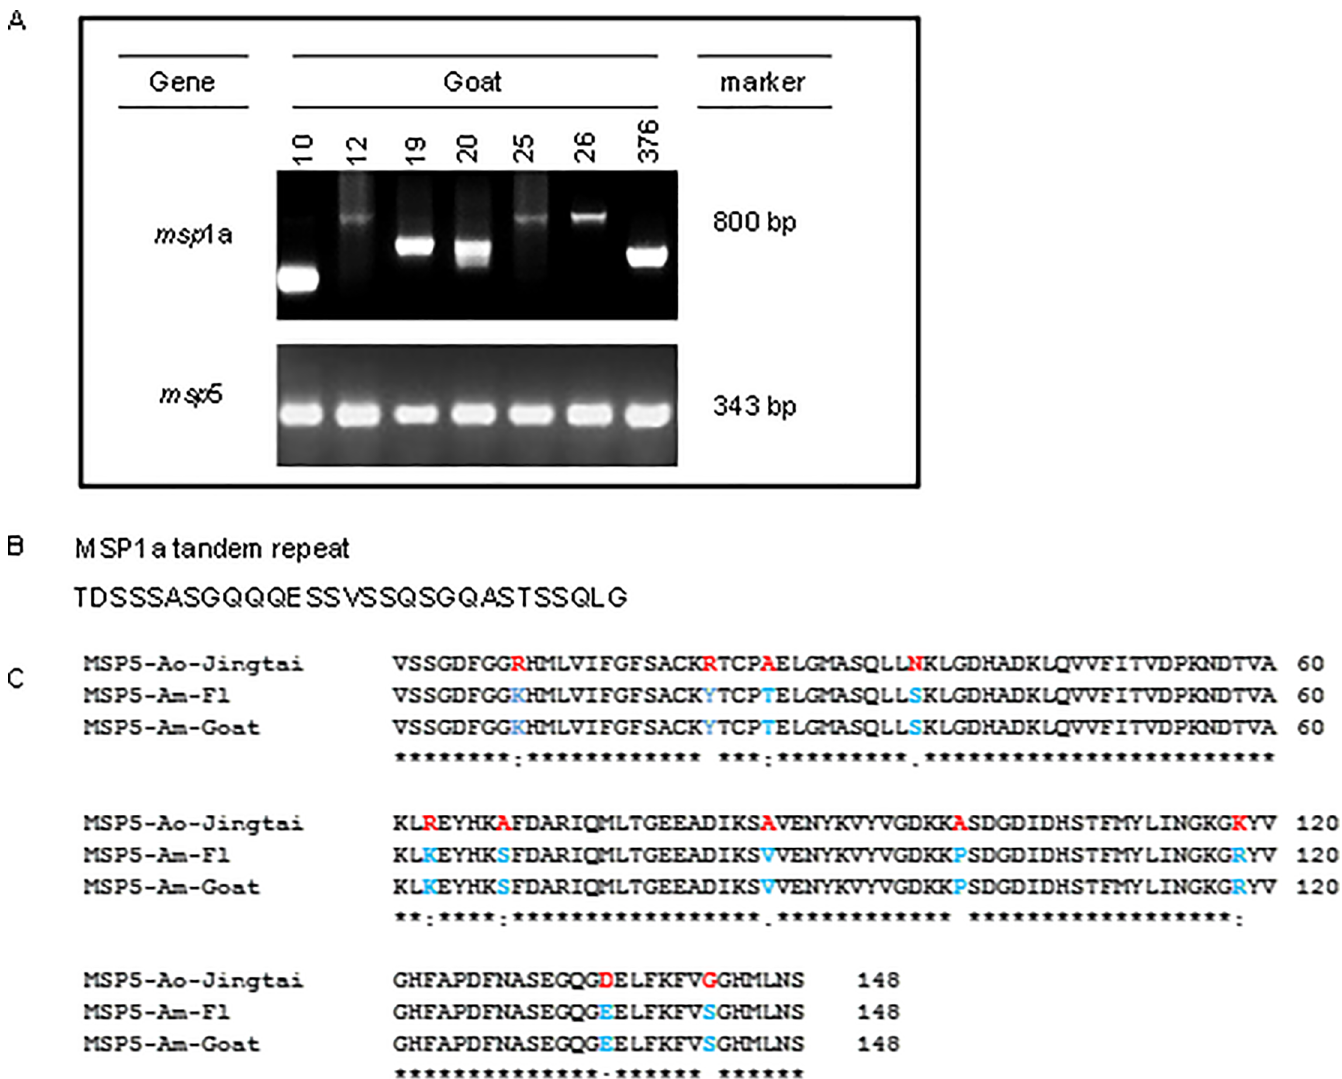
Fig 1. Detection of A . marginale msp 1aand msp 5genes in infected goats. A) 2% agarose gel detecting msp1a and msp5 , B) MSP1a tandem repeats and C) alignment of MSP5 between Anaplasma ovis (Ao Jintai), Anaplasma marginale Florida (Am-Fl) and Anaplasma marginale from a Brazilian goat (Am-Goat). Red indicates variation in the A . ovis MSP5 protein and blue highlights identical amino acids at the same location between Am-Fl and Am-Goat.